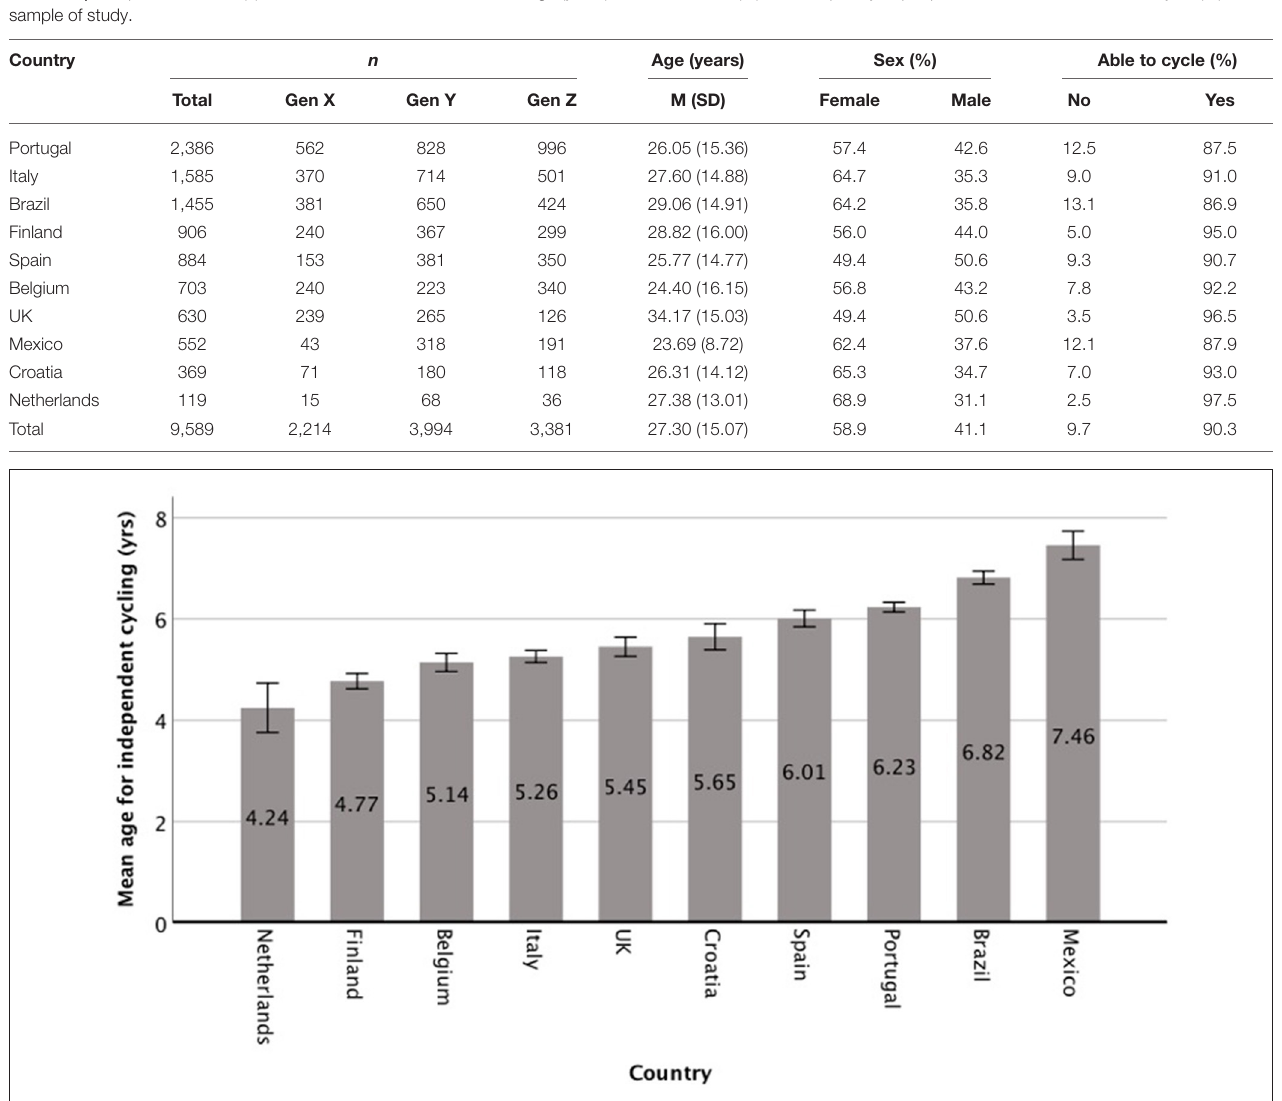
FIGURE 1 | Mean age to learn how to cycle independently by country. Error bars represent 95% CI. lower than in the other countries, except for the Netherlands, Finland and Italy (no significant differences). In Italy, learning age was significantly higher than in the Netherlands and Finland, and significantly lower than in all other countries; it was not significantly different than in Belgium, UK and